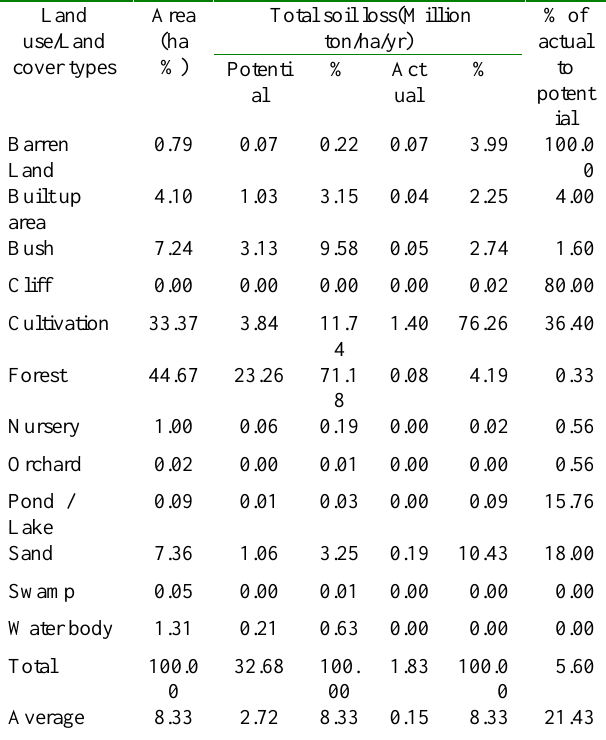
Table 5. Potential and actual soil loss by physiographic soil units Land